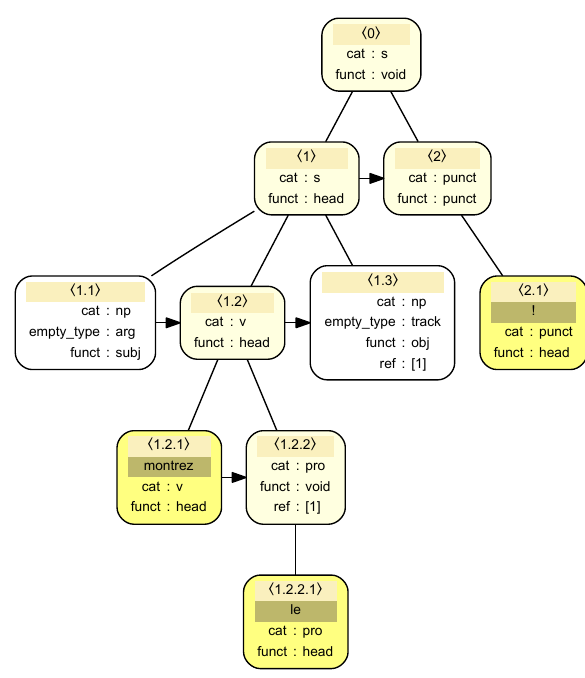
Figure 1: Parse tree representing the syntax of the sentence